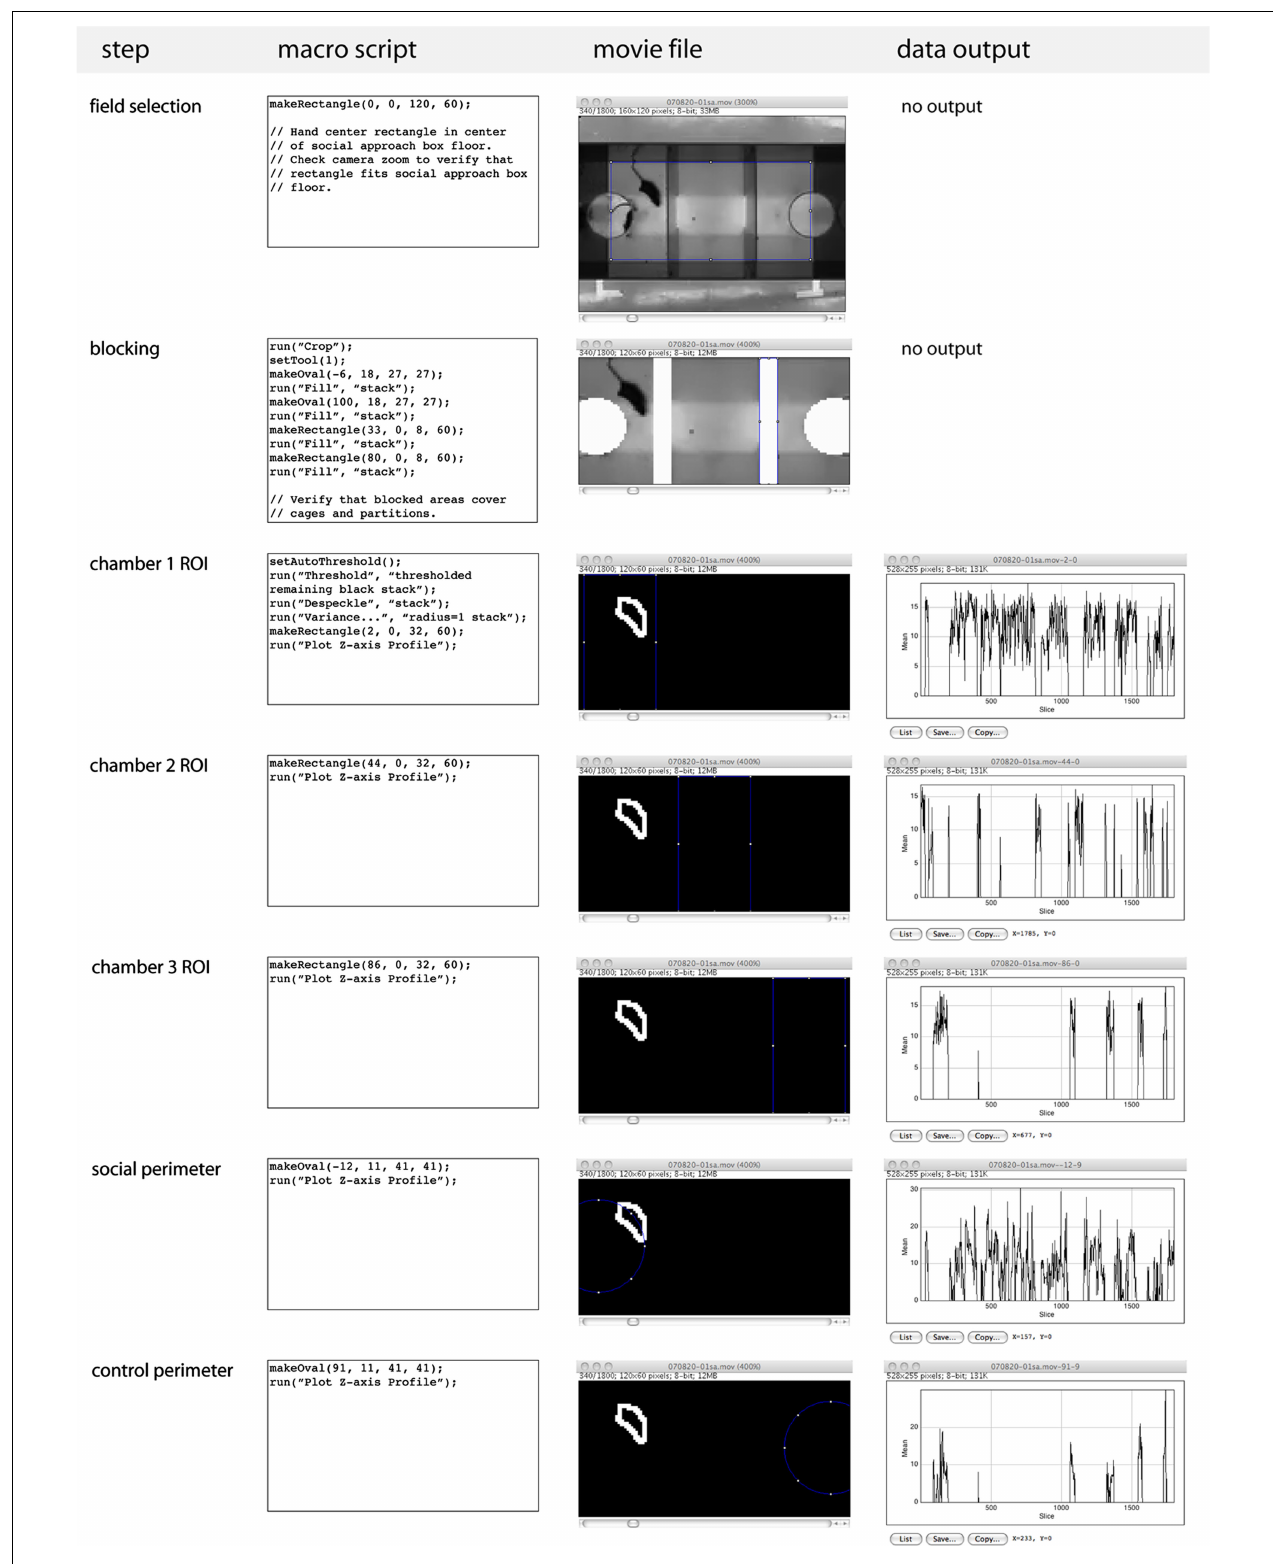
FIGURE 2 | Computer-assisted scoring of social approach. Processing of social approach movie fi les using ImageJ computer scripts. Scripts are run in order shown, data output shows signal in ROI over each frame of